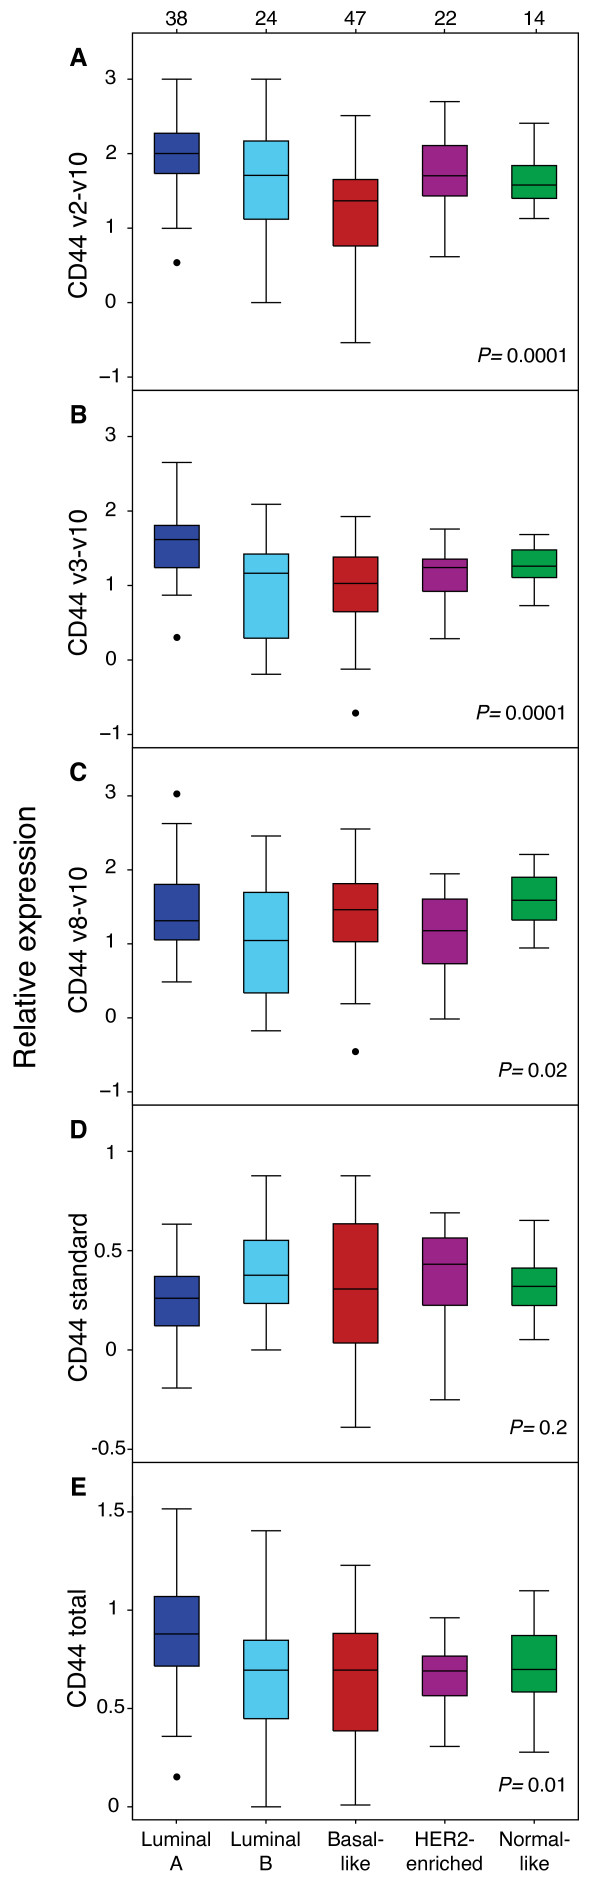
Expression of alternatively spliced transcripts of CD44 in breast cancer tumors classified into molecular subtypes. A-E. All isoforms except for the CD44 standard were differentially expressed in the different molecular subtypes. The CD44v2-v10 and CD44v3-v10 variants were highly expressed in luminal A tumors whereas the CD44v8-v10 isoform was associated to basal- and normal-like tumors. The CD44 standard variant had the highest median expression in HER2-enriched tumors. The numbers of tumors in each subtype are shown at top.